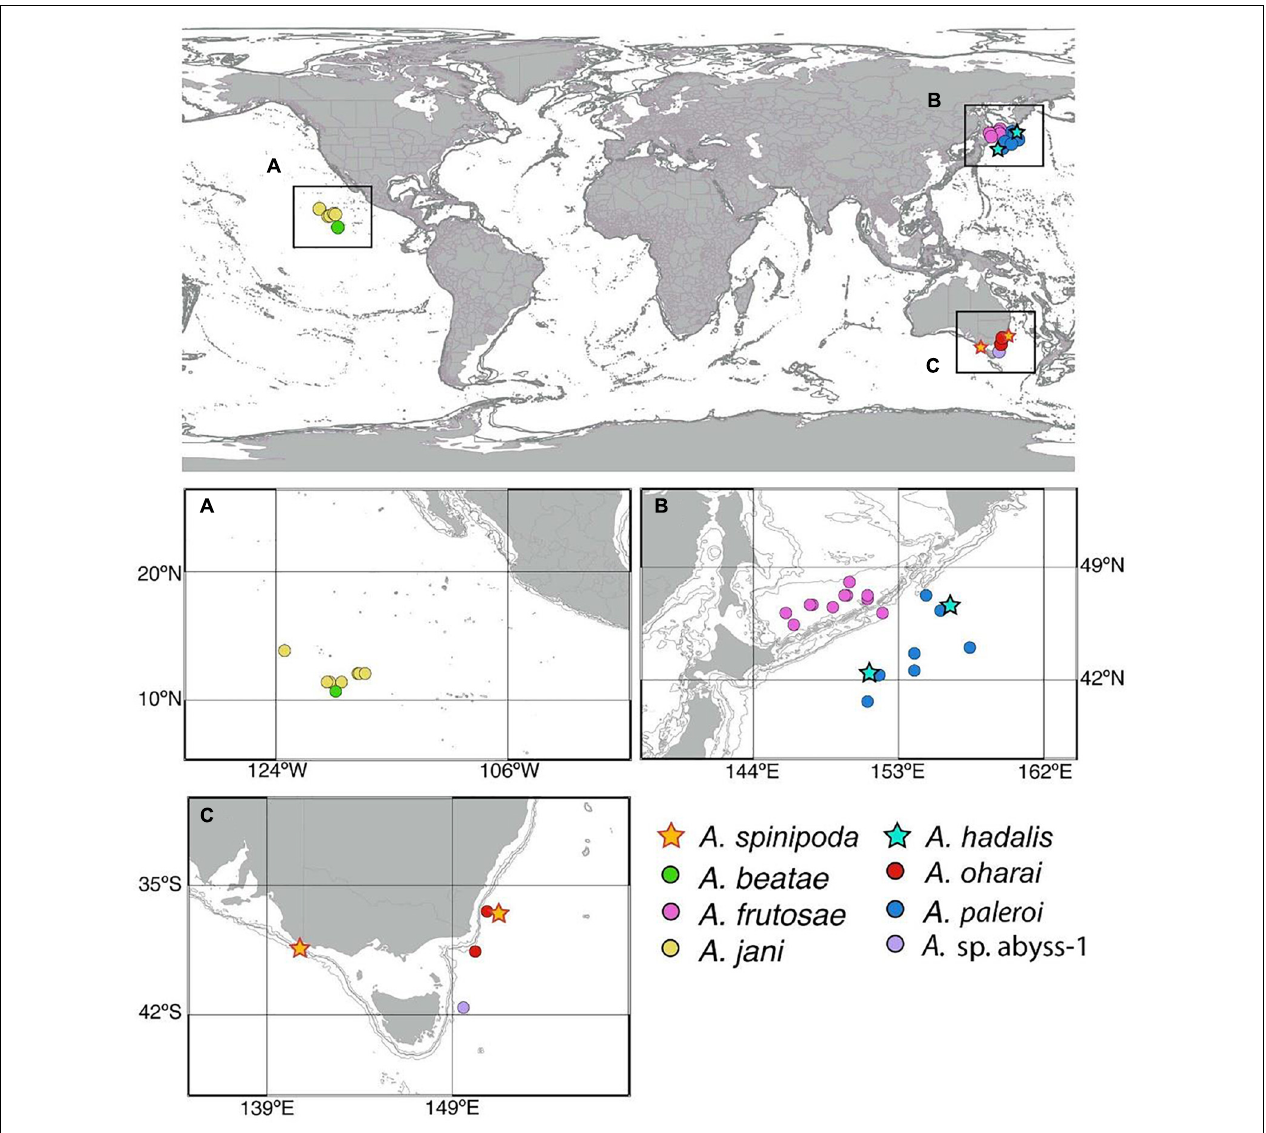
FIGURE 2 | Distribution of new species of Agathotanais collected from central Pacific (A) , Sea of Okhotsk, Kuril-Kamchatka Trench (KKT) (B) , and along Australian coast (C) .